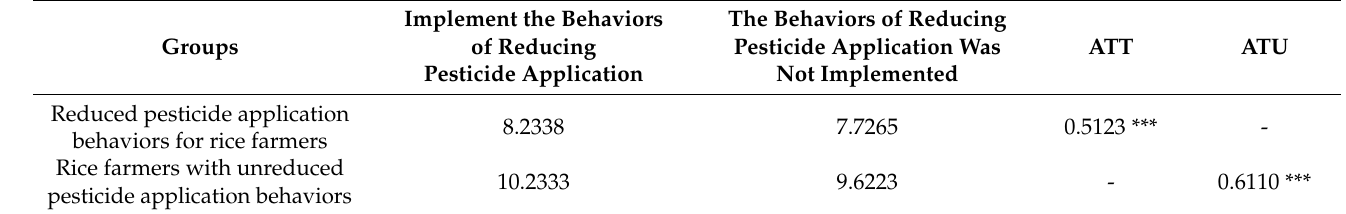
Table 6. Average treatment effect of rice farmers’ reduction of pesticide application behaviors on rice income and output.